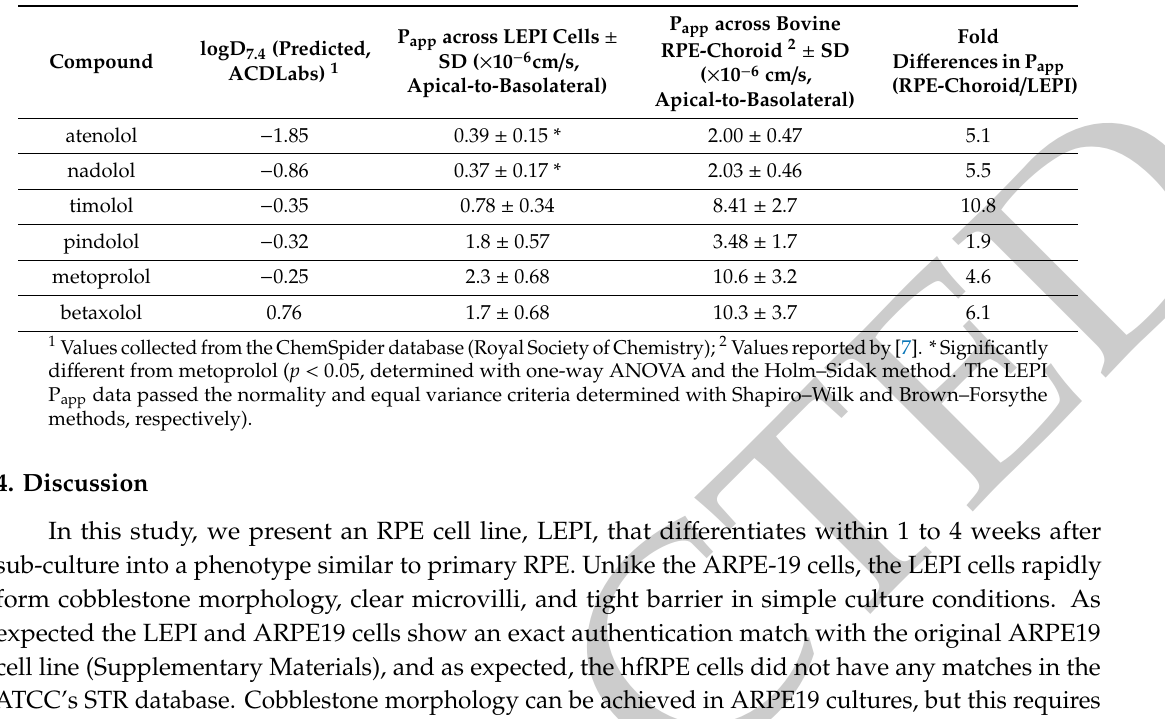
Table 2. Permeability of drugs across LEPI cells and bovine